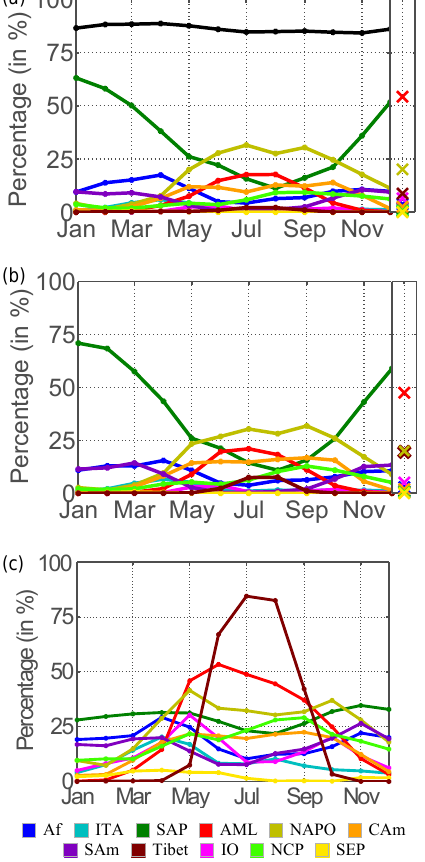
Figure 2. (a) Color lines: source distribution from backward calcu- lations, calculated as the proportion of backward trajectories reach- ing a convective top within a given region among all trajectories reaching a convective top. The sum of all the contributions is 100%. Black line: proportion of backward trajectories reaching a convec- tive top. (b) Source distribution from forward calculations, calcu- lated as the proportion of forward trajectories reaching the 380K isentropic surface from a given region among all the trajectories reaching this surface. (c) Efficiency of transport from convective tops, calculated as the proportion of parcels released in a given re- gion that reach the 380K isentropic surface in the forward calcula- tions. On the right of (a) and (b) : source distribution for the inside of the Asian monsoon anticyclone averaged over JJA. The statis- tics are obtained for the period 2005–2008. The time axis refers to the instant grouped by months where a parcel leaves (forward) or meets (backward) a cloud except for the black curve in panel (a) for which the time axis is that of the launch of the parcels on the 380K surface. Curves are plotted for each region, with the color code of Fig. 1.